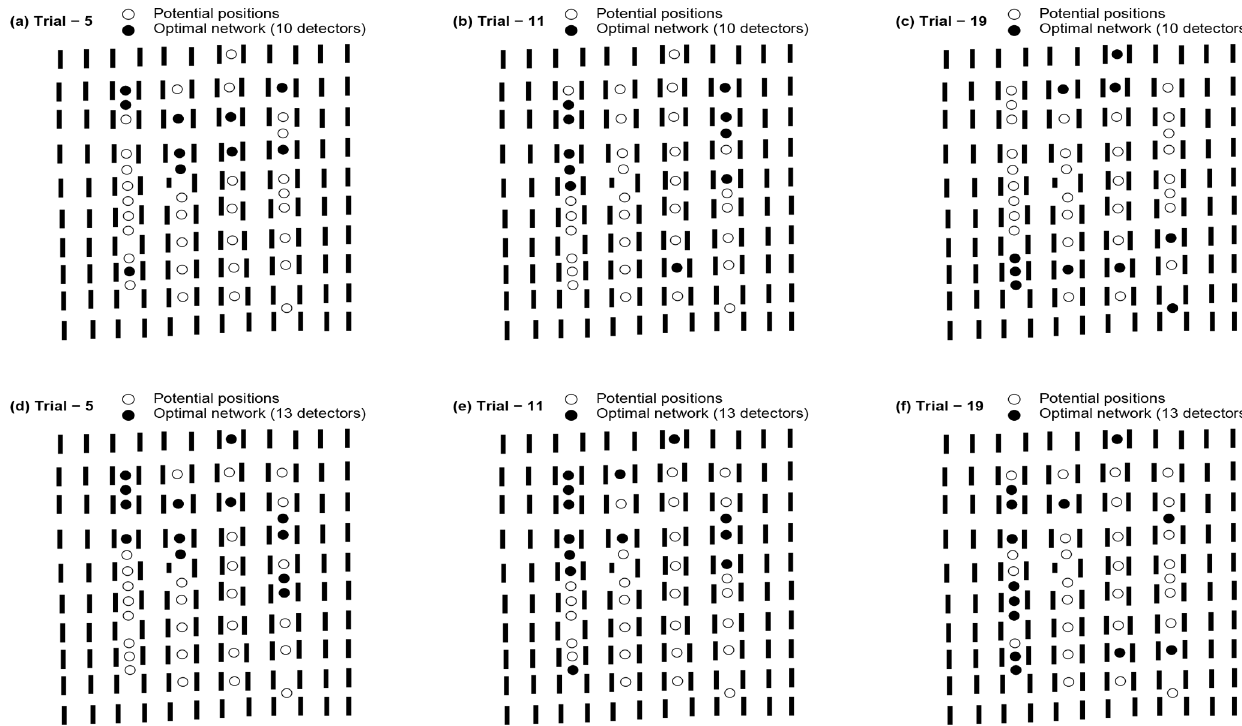
Figure 3. The optimal networks of 10 (a–c) and 13 sensors (d–f) , respectively, for trials 5 (very stable), 11 (neutral), and 19 (stable). Blank and filled black circles respectively represent all (40) potential positions and the optimal positions of sensors. Table 2. Source estimation results from the different monitoring networks for each selected trial of the MUST field experiment. E p E p q respectively denote the location error (m) and ratio of the estimated to true source intensity with the corresponding monitoring network. Here, the superscript p on E p and E p q represents the number of sensors in an optimal network. “Skeleton” refers to the number of sensors l common to the optimal networks of 10 and 13 sensors for a given MUST